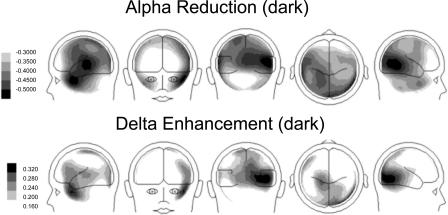
Difference Maps between Participants with Tinnitus and Controls for Alpha and DeltaThe results suggest that areas for which alpha reduction and delta enhancements are found partly overlap. Overall, the effect for the alpha band is considerably stronger (note that for this reason the scaling ranges are chosen differently).